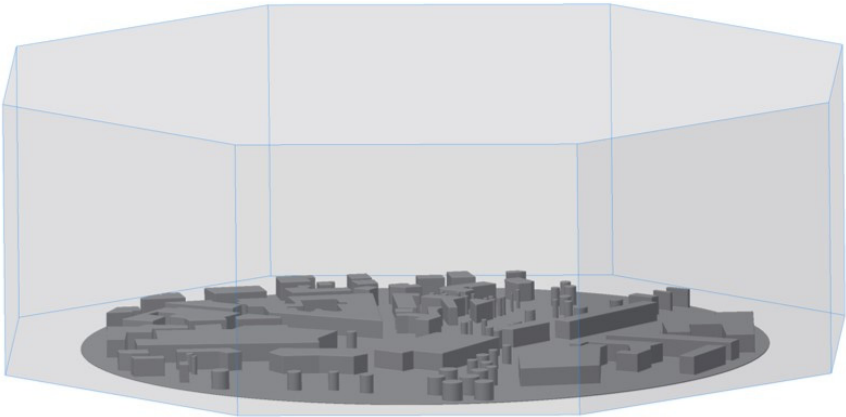
Figure 4. City model for flow simulation and analysis of particle dynamics.